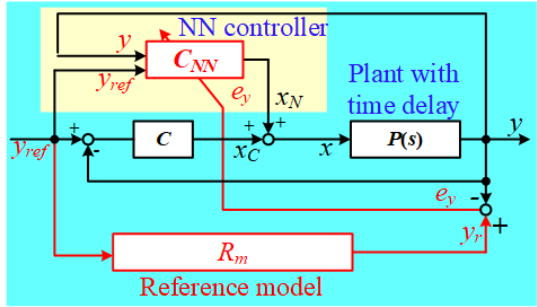
Figure 1. Block diagram of proposed reference-model-based ANN control